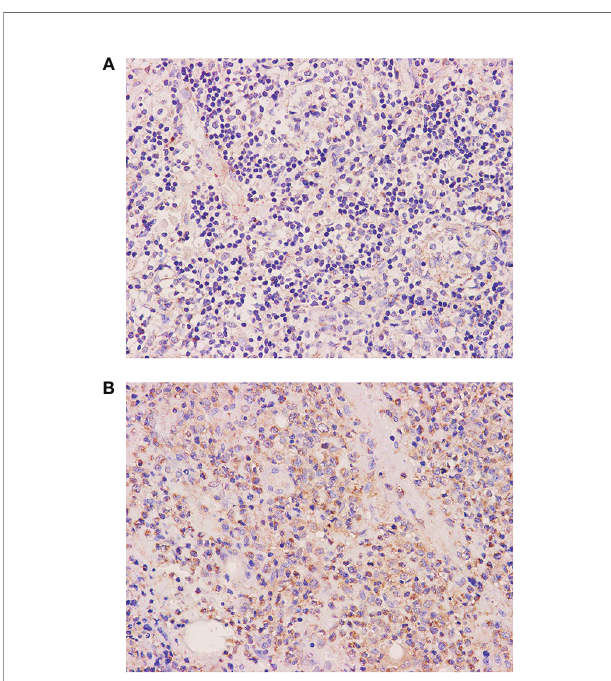
FIGURE 3 | Histologicalandimmunophenotypicresultsoftwoexcisionalbiopsies oflymphnodes.Immunohistochemicalstainingofexcisionalbiopsyoftheleft cervicallymphnodeshowstheexpressionofAID (A) .Immunohistochemical stainingofexcisionalbiopsyoftheaxillarylymphnodeshowsanincreaseofAID expressioninlargetransformedcells (B) .(magni fi